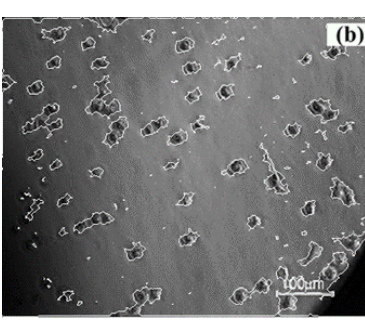
Figure 8 : Results after morphological operation Most of the cells in the image got detected but still the count was not correct. This difference in the count occurred due to closely connected cells, which were considered as one object. Fig 9(a) illustrates an example of connected cells scenario. The cell segmentation is one of the crucial and important part of the process. One of the classical method for segmentation used in the past is Watershed Algorithm [23][24]. Various improvements and variations of this method were generated and utilized due to its simplicity, speed and easily adjustable distance map factor [22][25][26].